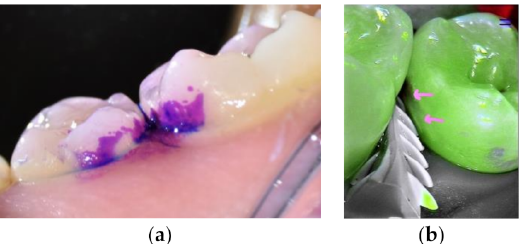
Figure 1. Premolars before and after cleaning using EMS biofilm discloser and an airflow with erythri- tol powder. ( a ) Biofilm daylight image after the application of a plaque disclosing dye (Soprolife TM camera). ( b ) An enamel white spot revealed after plaque cleaning (pink arrows, fluorescence image, Soprolife TM